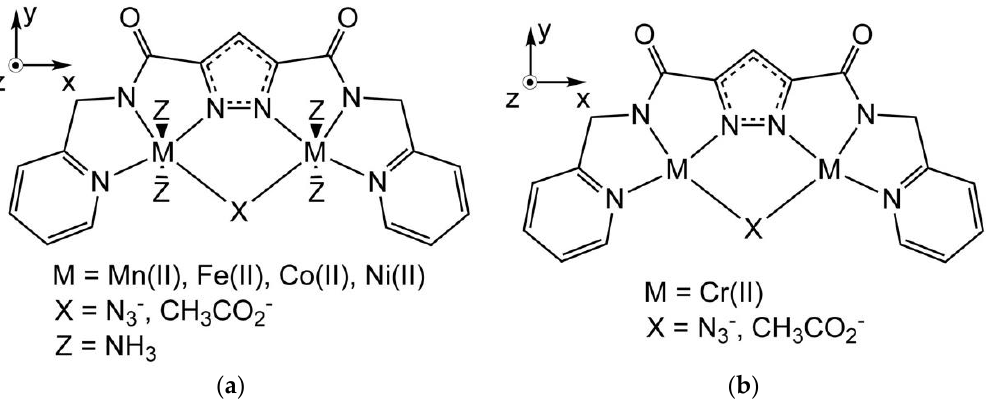
Figure 3. Illustration for pyrazole-bridged dinuclear metal complexes substituted by Mn(II), Fe(II), Co(II), Ni(II) ions ( a ), and Cr(II) ions ( b ). Note that a square planar structure is assumed for the Cr(II) complexes because the octahedral structure is not obtained by the geometry optimization.